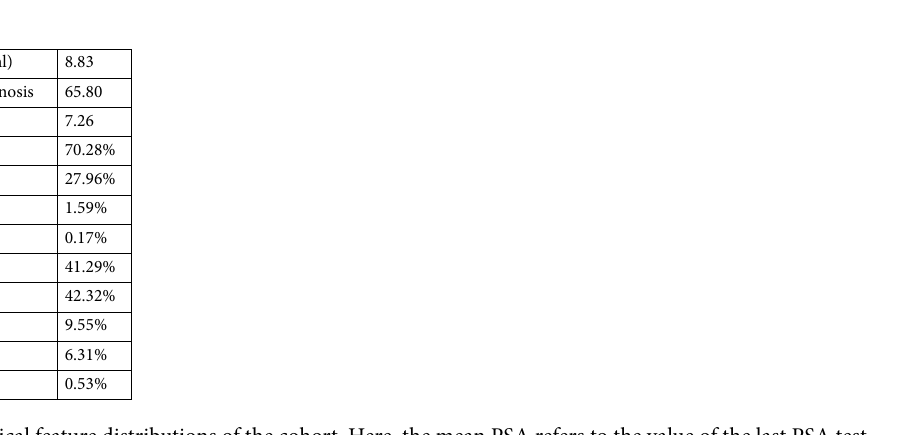
Table 1. Clinical feature distributions of the cohort. Here, the mean PSA refers to the value of the last PSA test prior to diagnosis. PSA counts is the number of PSA tests up to 10 years before diagnosis. The Gleason score is the sum of primary and secondary scores.